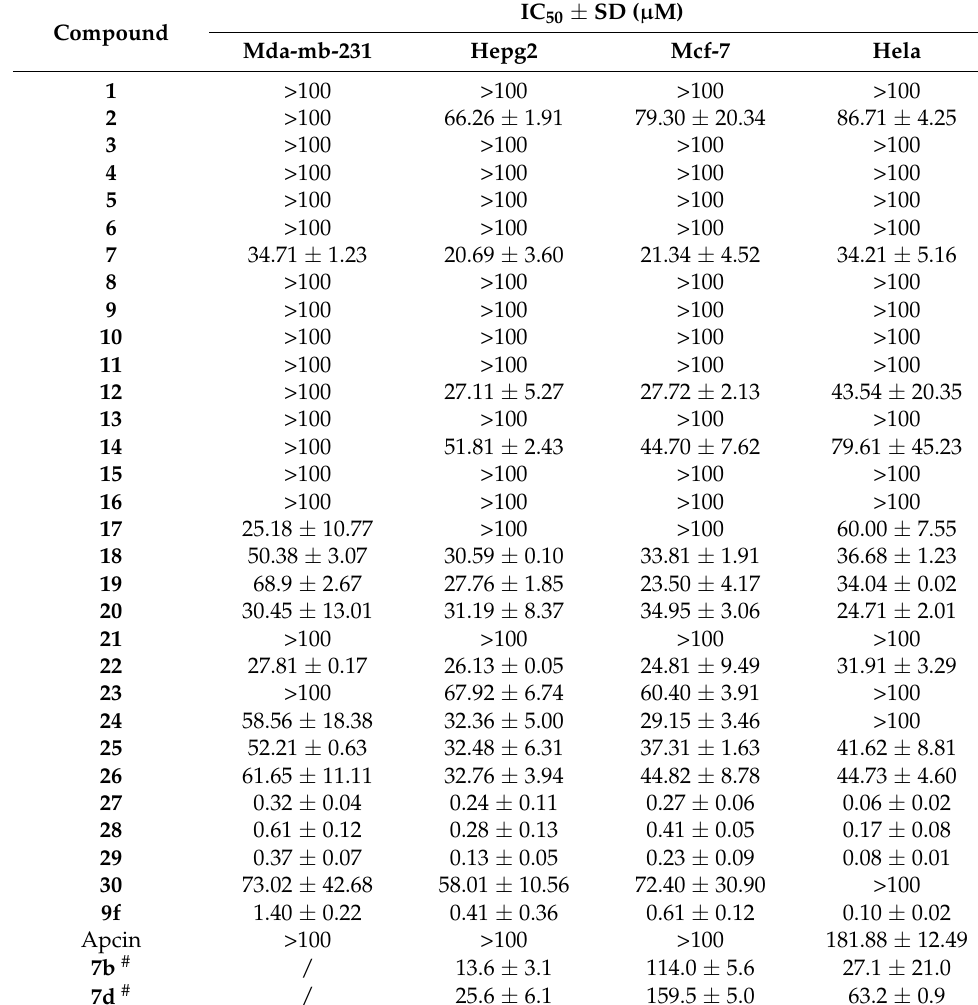
Table 2. In vitro cell-growth inhibitory effects of compounds